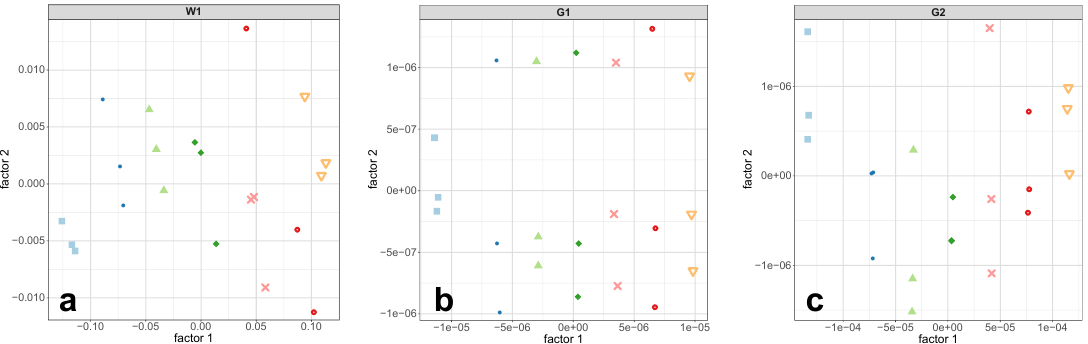
Figure 7. PLS-R score plots of the calibration set for the regions W1 ( a ), G1 ( b ), and G2 ( c ) obtained by measurements with the 1 mm cell. Each data point corresponds to one batch. The featured factors were chosen according to the required number of PLS-R factors in Table